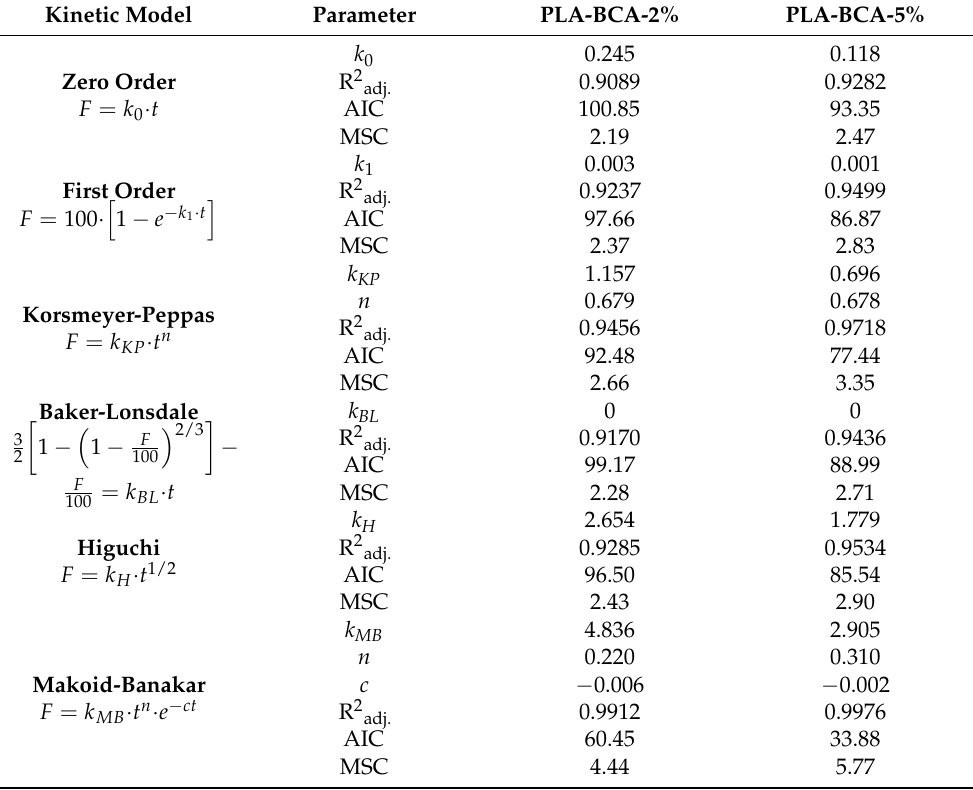
Table 5. Applied kinetic models and obtained